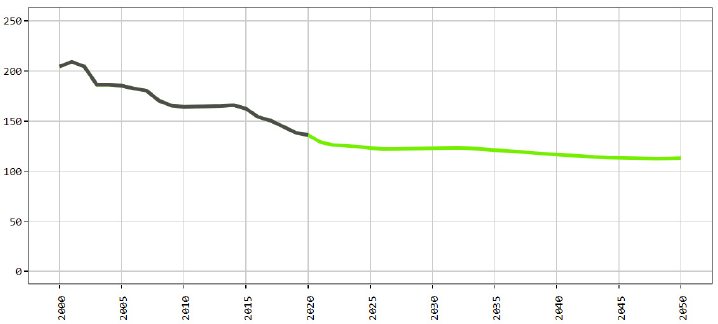
Figure 11. Number of dairy cows in Latvia in 2000–2020, with a projection for 2021–2050, thousands [62].